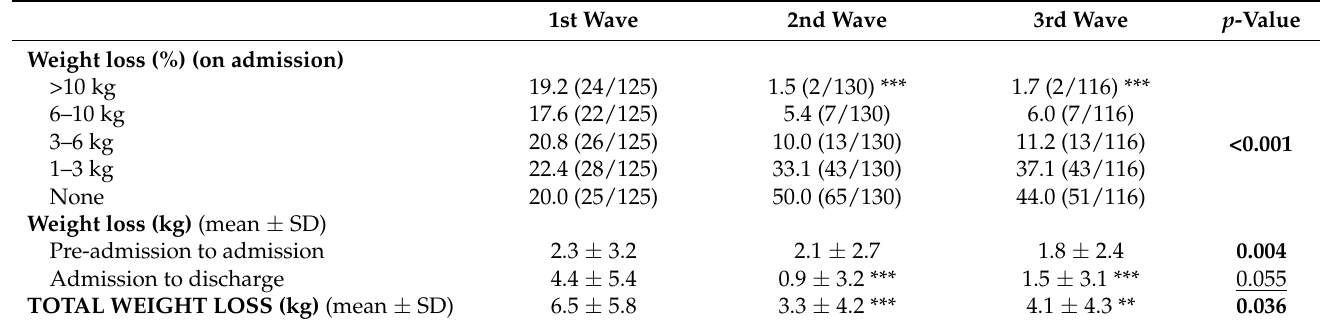
Table 5. Weight loss comparative between the three waves of COVID-19